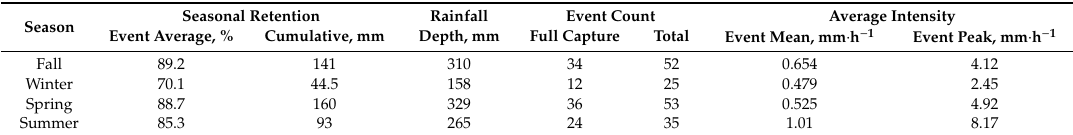
Table 3. Retention by season for the OnCenter green